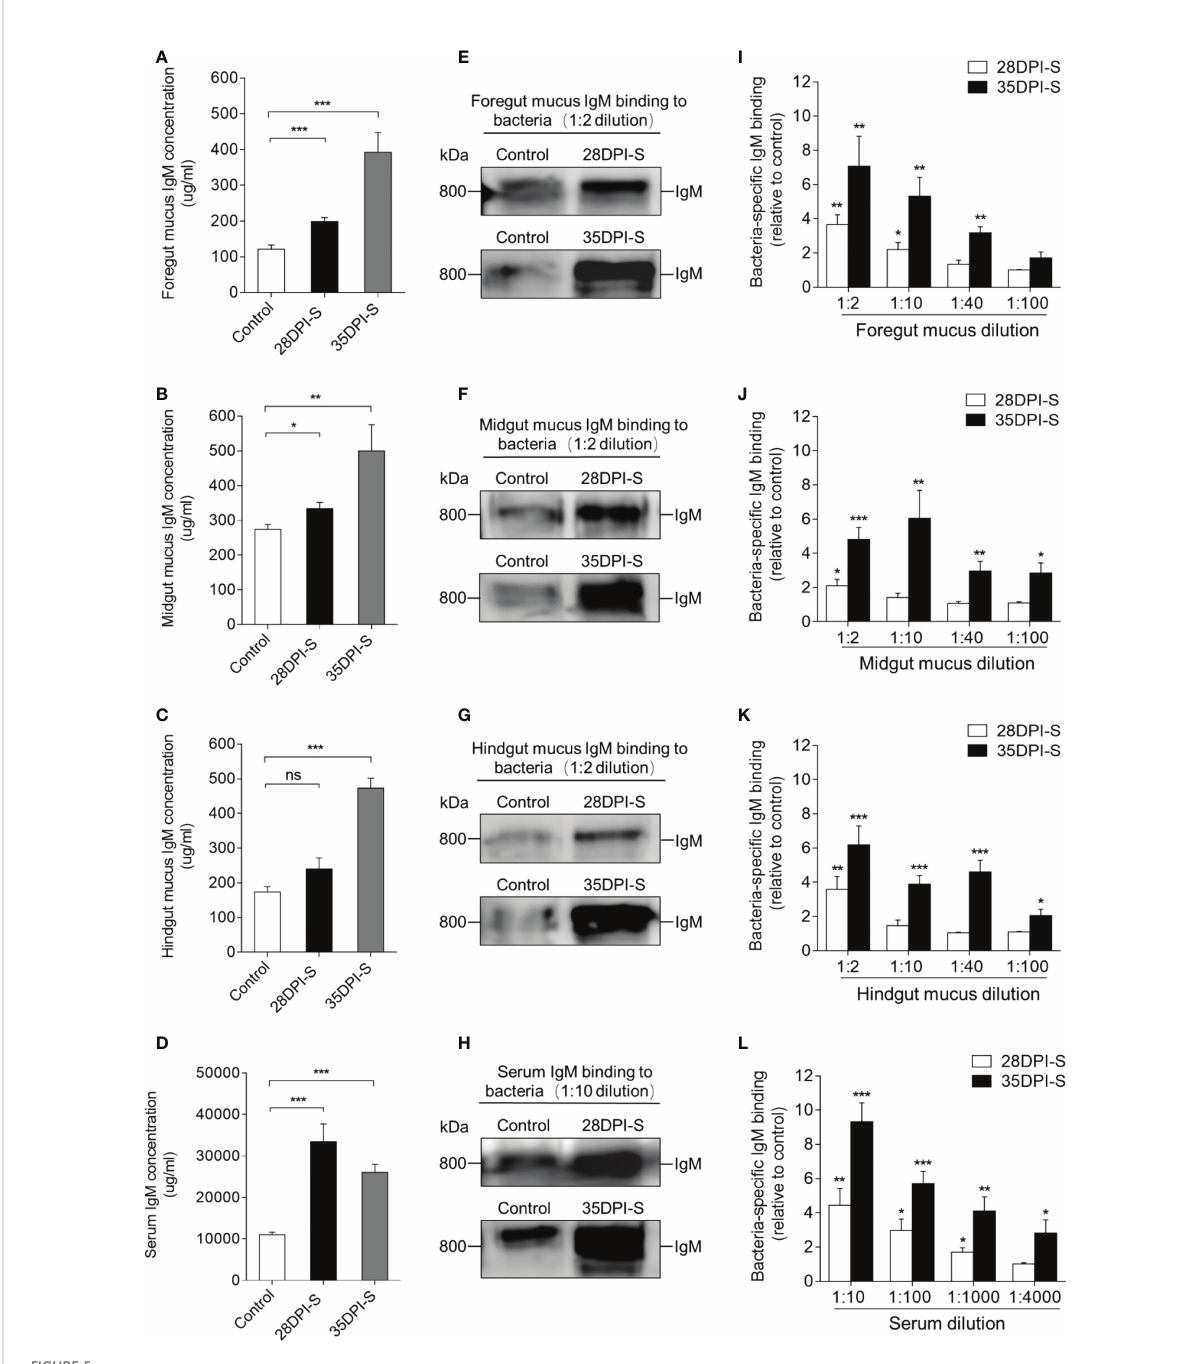
FIGURE 5 IgM responses in the gut mucus and serum from 28DPI-S and 35DPI-S fi sh. (A – D) The concentration of IgM protein in foregut mucus (A) , midgut mucus (B) , hindgut mucus (C) , and serum (D) of Control, 28DPI-S, and 35DPI-S fi sh ( n = 6). (E – H) Western blot analysis of IgM-speci fi c binding to A . hydrophila in foregut mucus (E) , midgut mucus (F) , hindgut mucus (G) , and serum (H) (mucus dilution 1:2; serum dilution 1:10) from 28DPI-S and 35DPI-S fi sh. (I – L) IgM-speci fi c binding to A. hydrophila in dilutions of foregut mucus (I) , midgut mucus (J) , hindgut mucus (K) , and serum (L) from 28DPI-S and 35DPI-S fi sh, evaluated by densitometric analysis of immunoblots and presented as relative values to those of control fi sh ( n = 6). ns, not signi fi cant, * P < 0.05, ** P < 0.01, and *** P < 0.001 (unpaired Student ’ s t -test). Data are representative of at least three independent experiments (mean ±